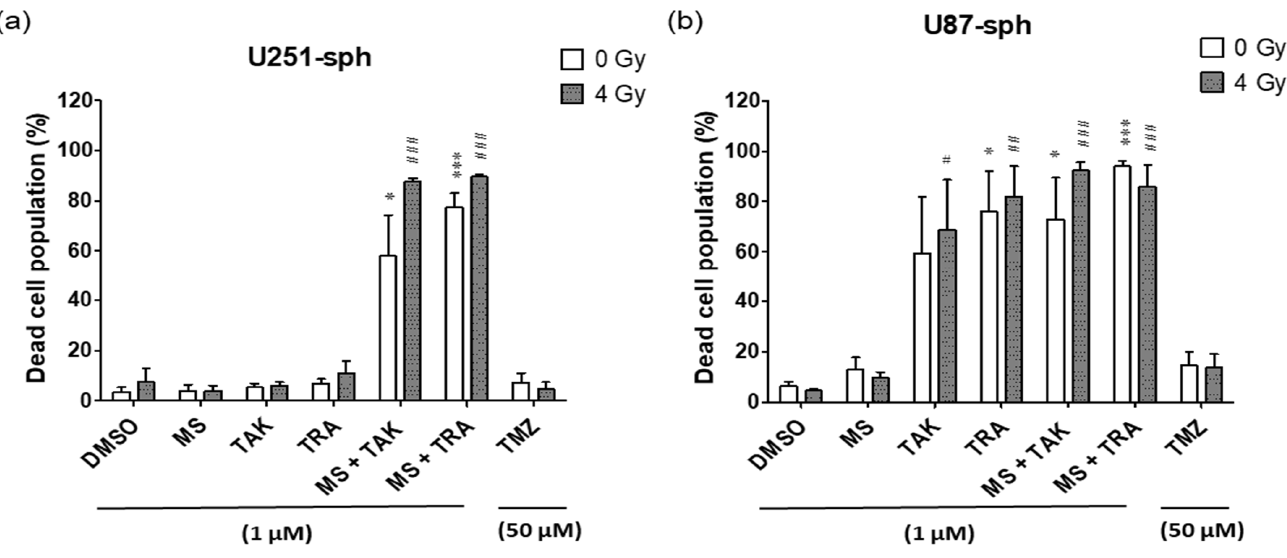
Figure 7. High population of dead cells in GB-derived spheres after treatment with HDACi or MEKi as single or combined compounds with radiation. Quantification data showing the percentage of dead cells in ( a ) U251-sph and ( b ) U87-sph after the different treatment conditions. Data represent mean values ± SEM ( n = 3). Asterisks indicate significant differences between 0 Gy DMSO and treated samples using Student’s t -test: * p ≤ 0.05 and *** p ≤ 0.001, while hash symbols indicate significant differences between 4 Gy DMSO and 4 Gy treated samples using Student’s t -test: # p ≤ 0.05, ## p ≤ 0.01 and ### p ≤ 0.001.